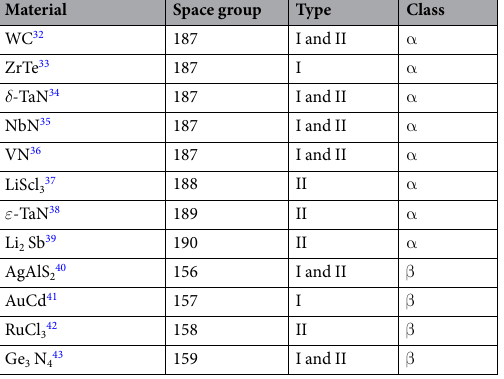
Table 1. A list of candidates for the new topological